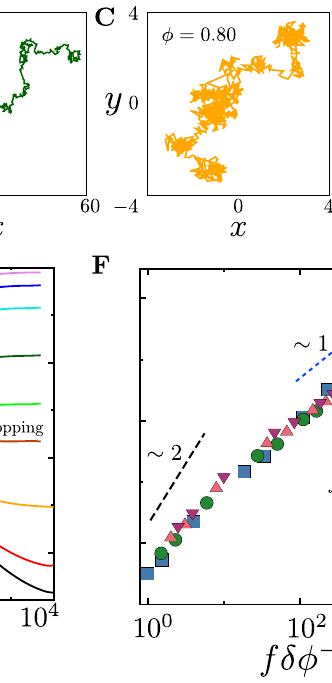
errors are very small, less than1% of theactualvalues. F Crossoverscaling collapse ofthelatetimediffusioncoef fi cient D ∞ ( ϕ , f ),describedin(2),inthescalingvariable y ≡ f / δϕ ν , where δϕ (0.026 ≤ δϕ ≤ 0.770) is the deviation from the MCT value, μ ≈ 6.5and ν ≈ 2.5. Thedashed lines ϕ MCT ( f ).The scaling exponents are found to be suggest a crossover of the scaling function from D ð y Þ ! y 2 to D ð y Þ ! y , as y